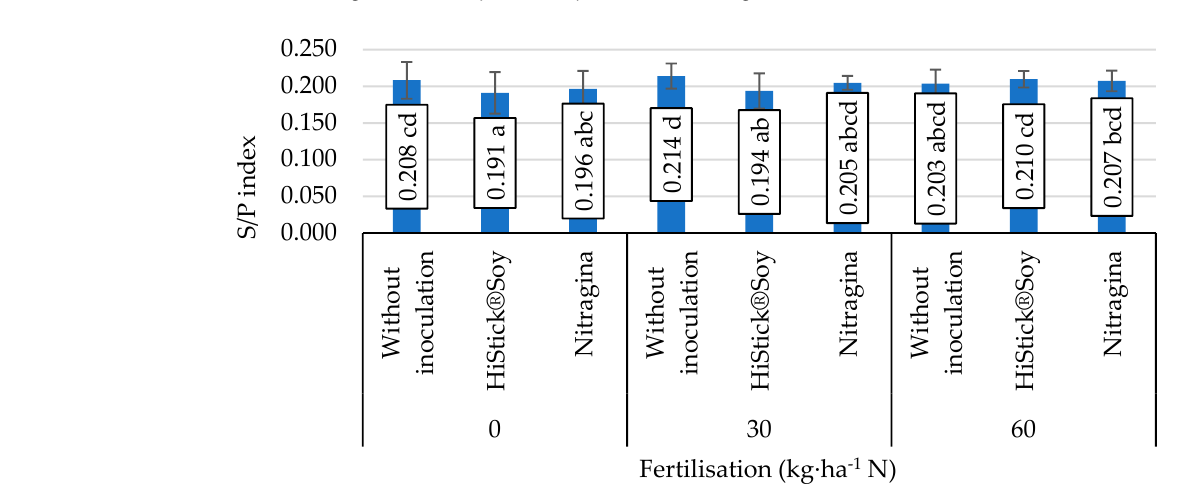
Figure 3. Value of the saturation fat index (S/P), mean values for interaction nitrogen fertiliser application × inoculation. Mean values ± SD. Means followed by different superscripts show significant differences ( p < 0.05) according to the post-hoc Tukey test. Differences significant at: ** p < 0.01.